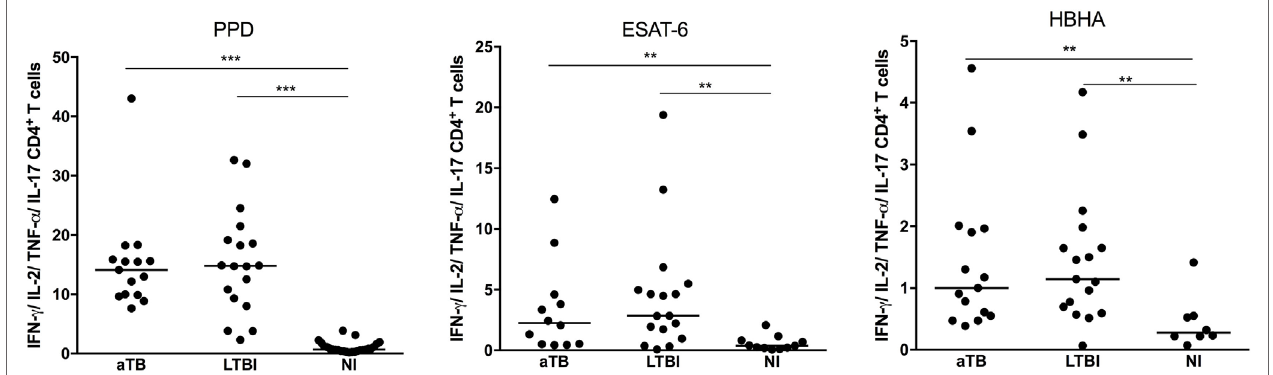
FigUre 2 | Mycobacterium tuberculosis -specific cytokine expression by CD4 + T lymphocytes. Peripheral blood mononuclear cells were in vitro stimulated during 5 days with purified protein derivative (PPD), early-secreted-antigenic target-6 (ESAT-6), or heparin-binding hemagglutinin (HBHA), and the percentages of CD4 + T lymphocytes expressing one or several of the four studied cytokines (IFN- γ , TNF- α , IL-2, IL-17) were measured by flow cytometry. Children with active TB (aTB) were compared to latently TB infected (LTBI) and non-infected (NI) children. Each dot corresponds to the result from an individual child and horizontal bars represent the medians of the results. *** p < 0.001; ** p <